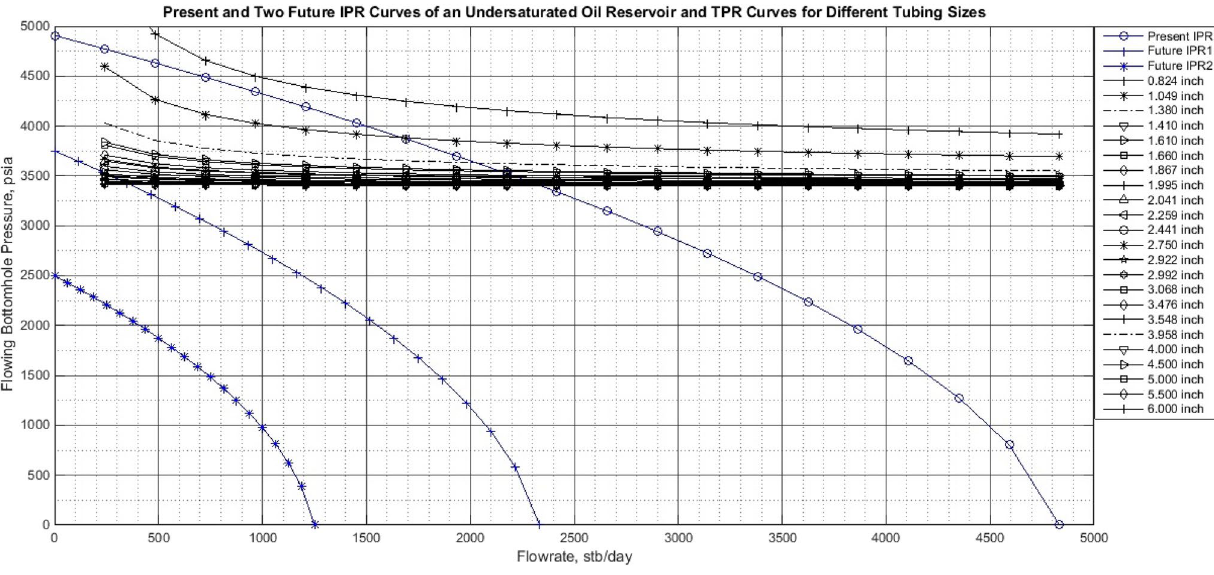
Fig. 5 Present and two future IPR curves of an undersaturated oil reservoir and TPR curves for different tubing